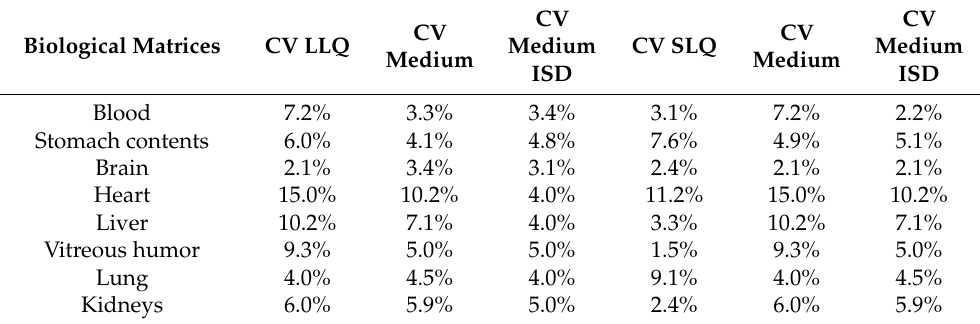
Table 17. Coefficient of variation (CV) of the lower limit of quantification (LLQ) and the superior limit of quantification (SLQ), as well as the average CV (average of the CV of the other points of the calibration curve), and of the internal standard (ISD) in the different matrices, expressed in percentage of aldicarb–sulfoxide.